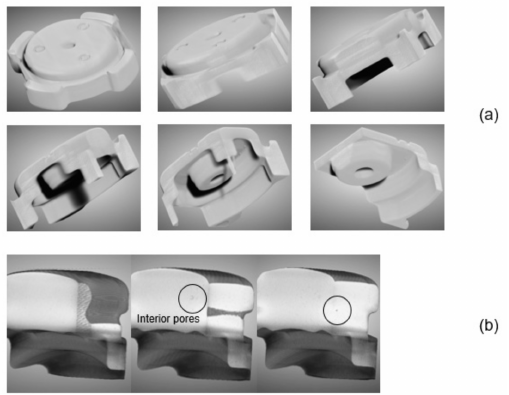
Figure 7. XCT images of ( a ) the whole body and ( b ) the leg of the green part.